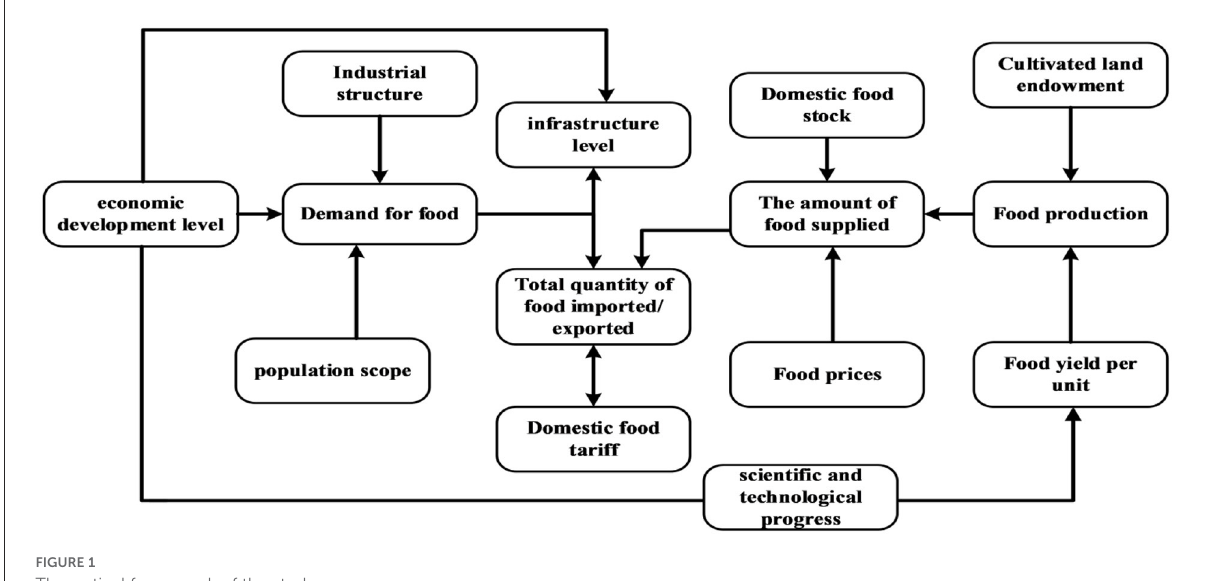
FIGURE1 Theoretical framework of the study.